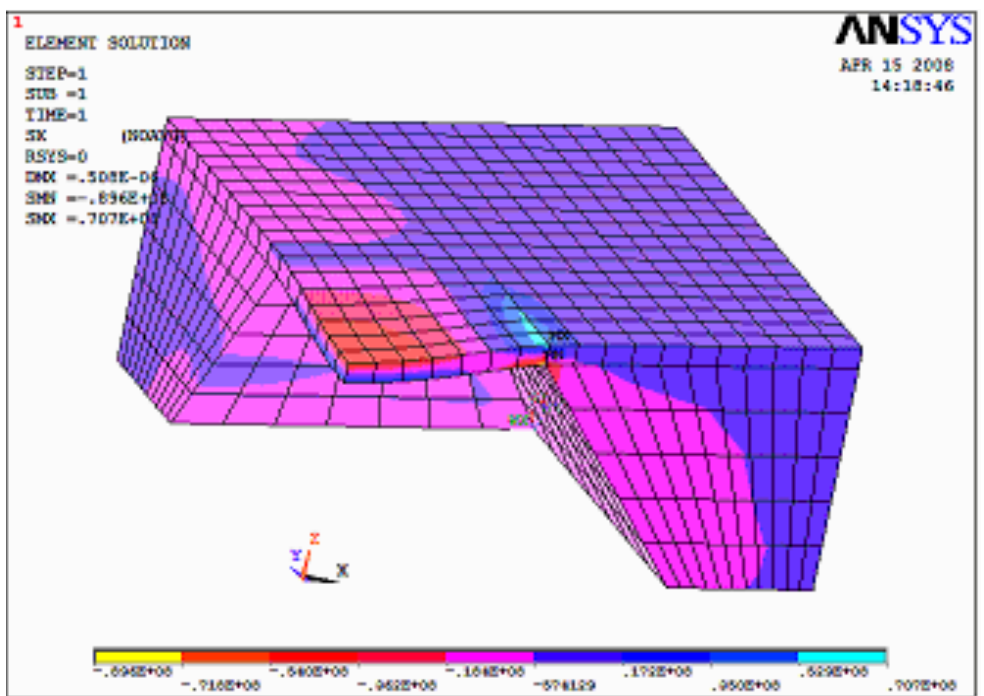
Figure 1. X-direction stress distribution, the gauge of most strain is 707 micro strains that concentrated in the blue